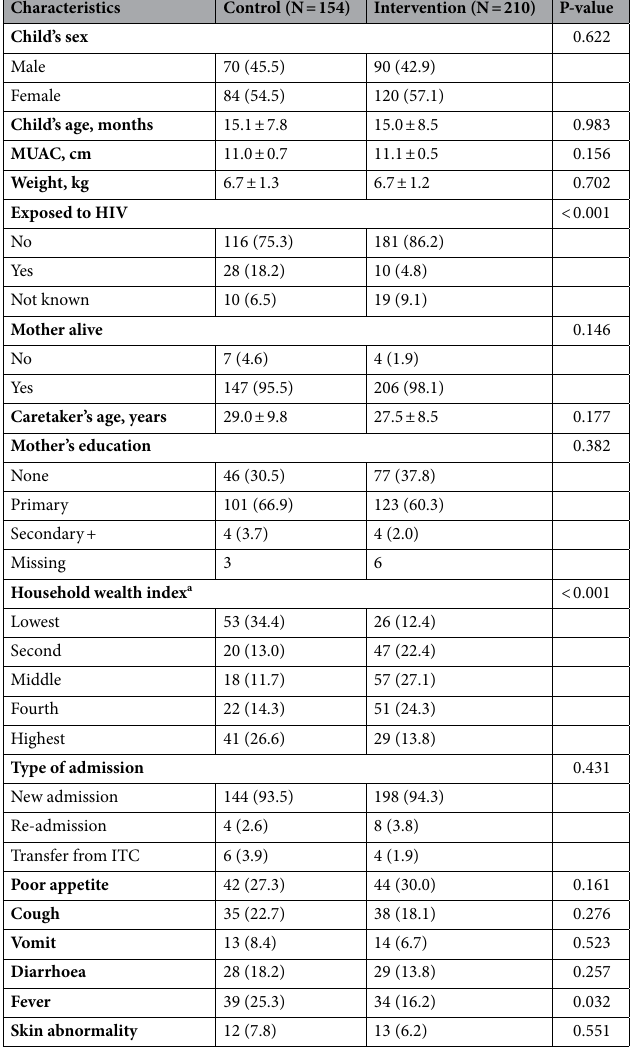
Table 1. Characteristics of study participants at recruitment. Data are presented as n (%) for categorical variables or Mean ± SD for continuous variables. a Derived using principal components analysis of household assets, access to utilities and type of housing